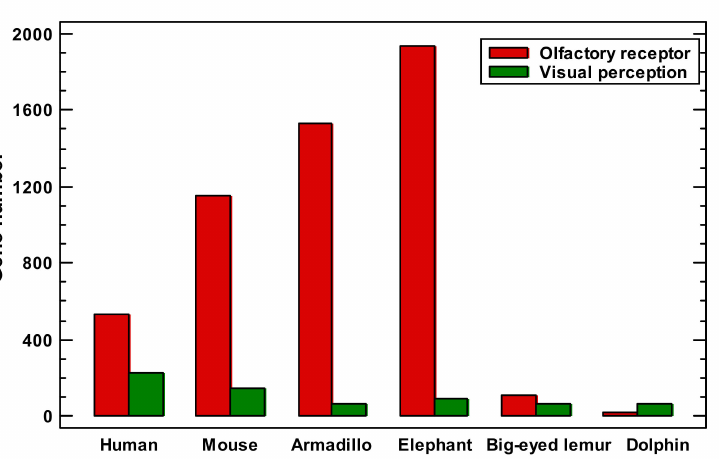
Figure 3. The numbers of olfactory receptors and visual-perception genes in different